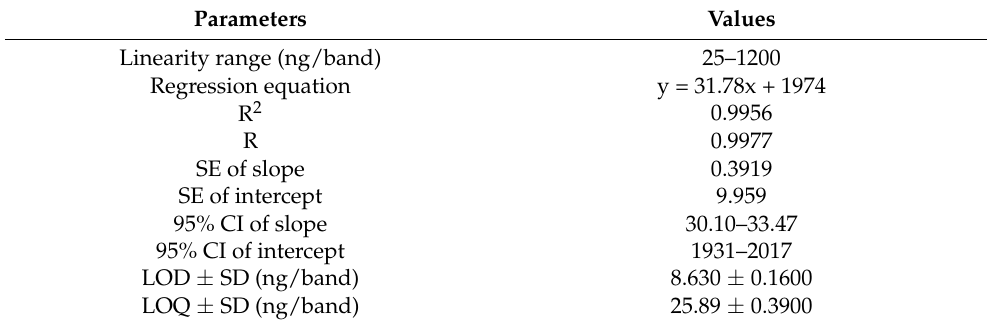
Table 2. Results of the regression analysis for the estimation of AA using the greener HPTLC method a .